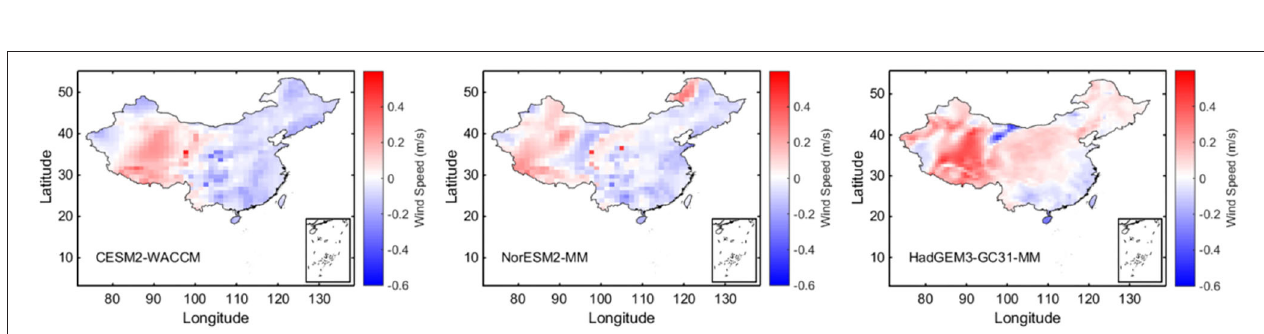
FIGURE 6 | The spatial distribution of wind speed bias (ssp5-8.5 minus historical) from CESM2-WACCM, NorESM2-MM, and HadGEM3-GC31-MM.